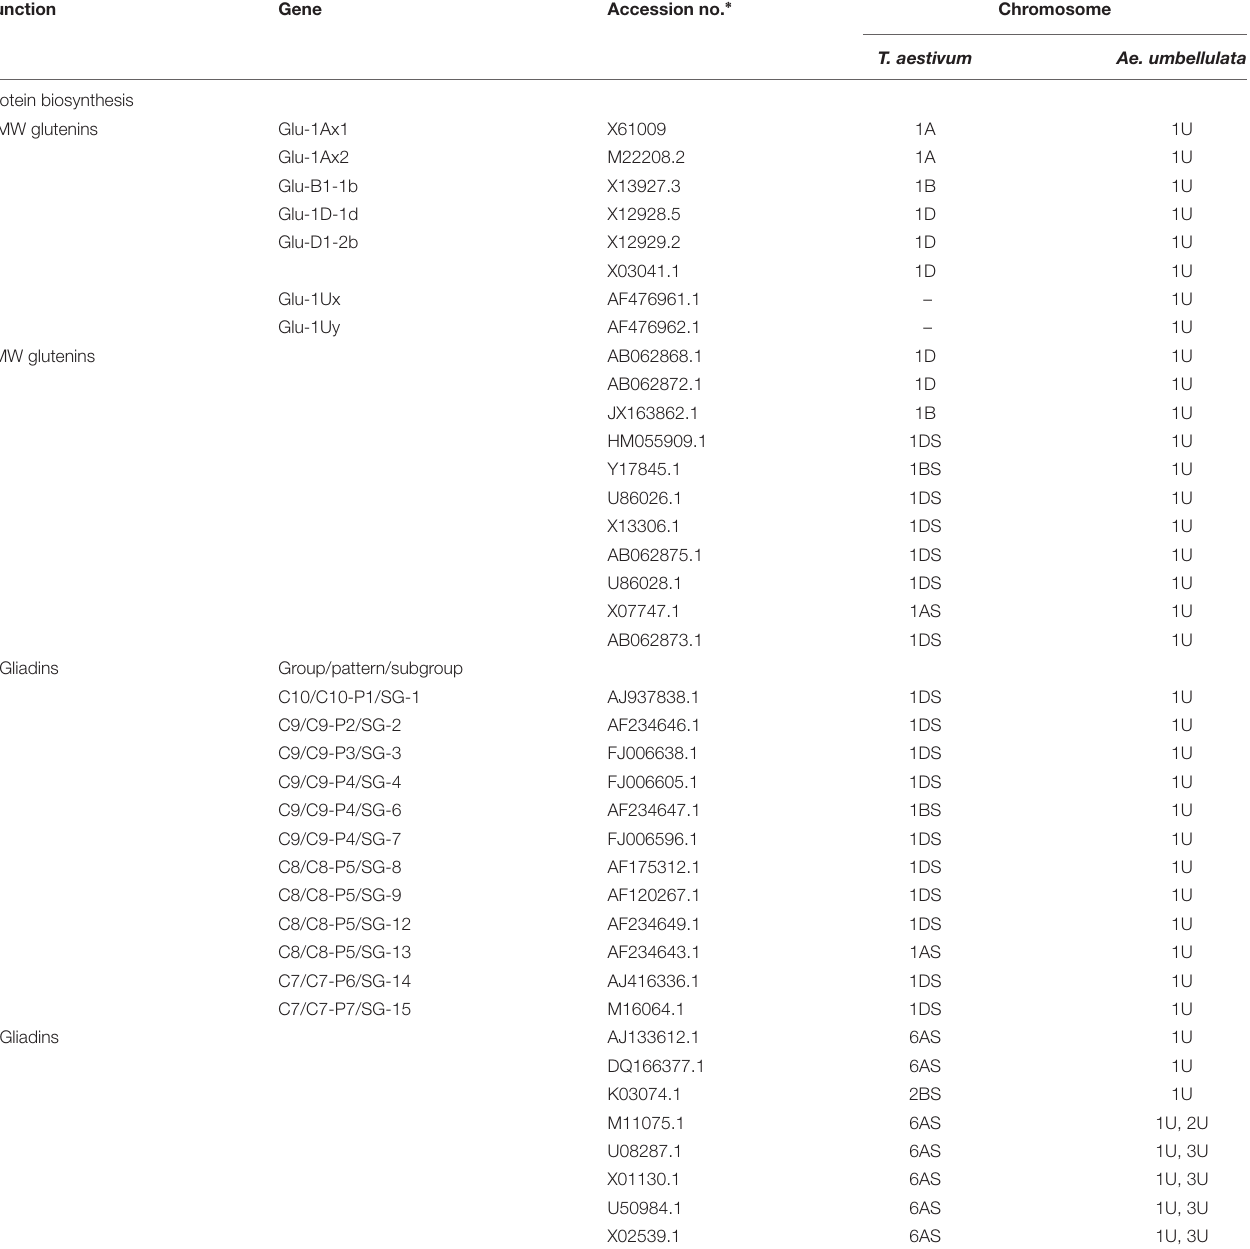
TABLE 1 | Chromosomal assignment of genes responsible for grain storage protein biosynthesis in hexaploid wheat and Ae. umbellulata . Function